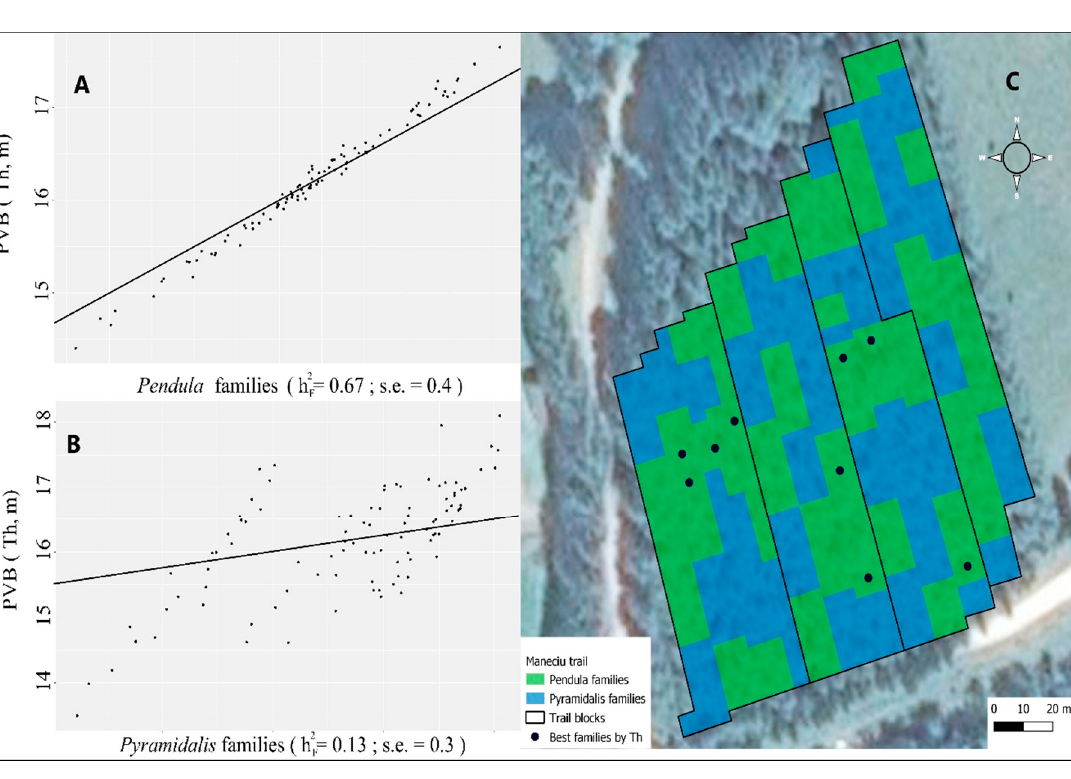
Figure 2. Predicted breeding values (PBVs) for pendula ( A ) and pyramidalis ( B ) families, according to Th, and the spatial distribution ( C ) of the two forms in the M ă neciu trial. The most valuable pendula families are